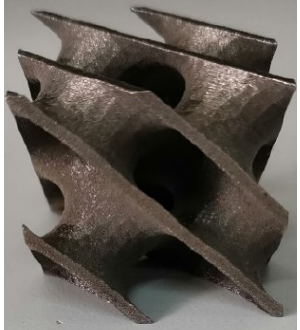
Figure 1. D structure specimen.